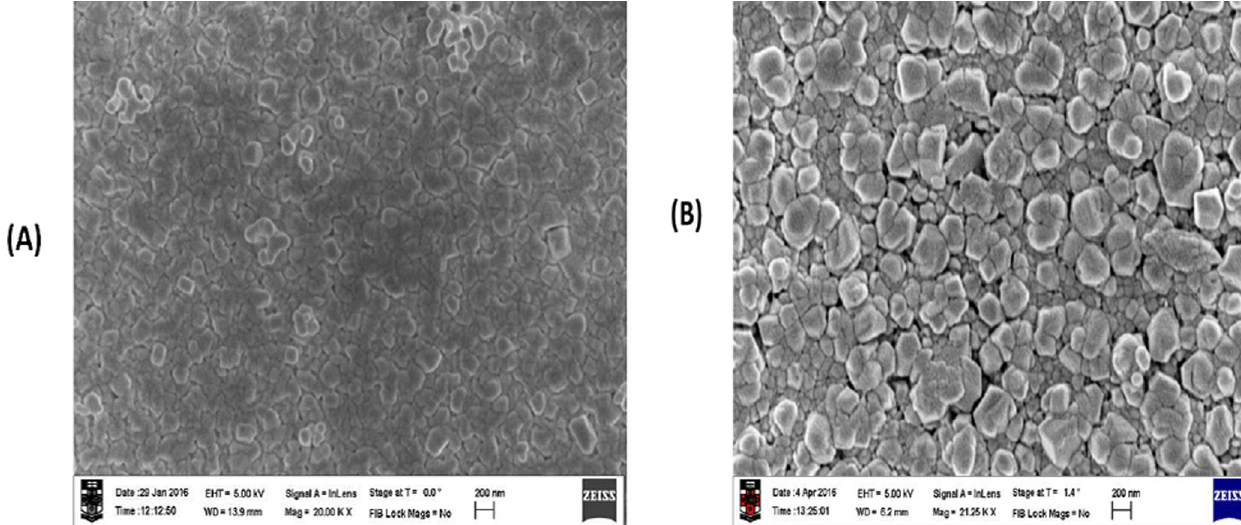
Fig. 1. Surface morphology view (SEM image) of MA 0.6 FA 0.4 PbI 3 perovskite fi lm on top of (A) ZnO and (B) Al doped ZnO (AZO) fi